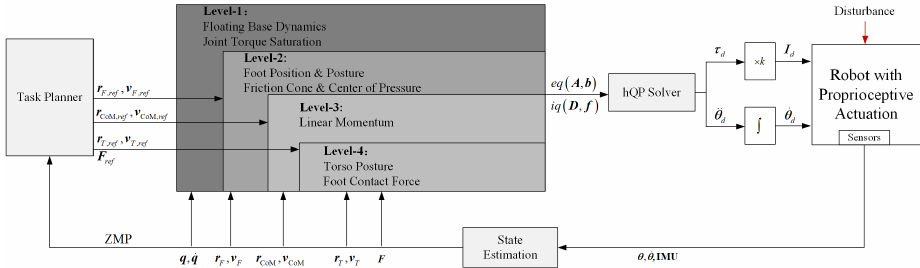
Figure 2. Overview of the control